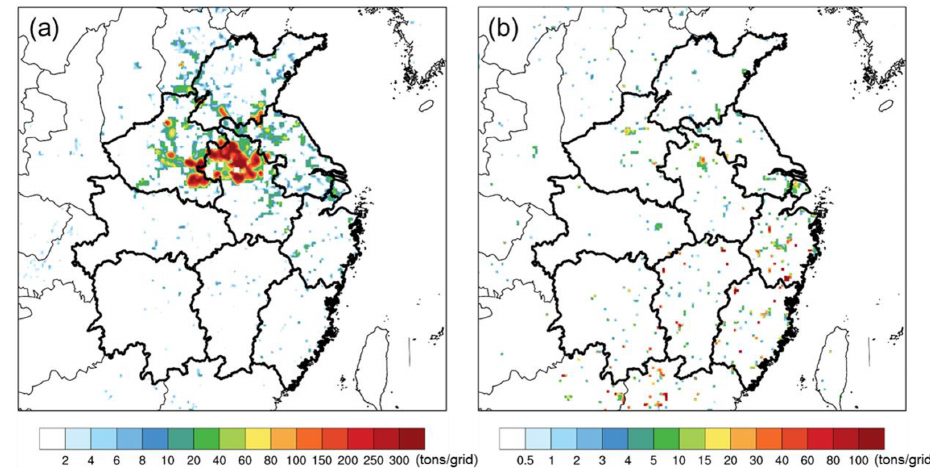
Figure 8. Spatial distributions of constrained PM 2 . 5 emissions from (a) OCSB and (b) other types of OBB for the study period. The maps were created by NCAR Command Language (NCL) (http://www.ncl.ucar.edu/, last access: 18 December